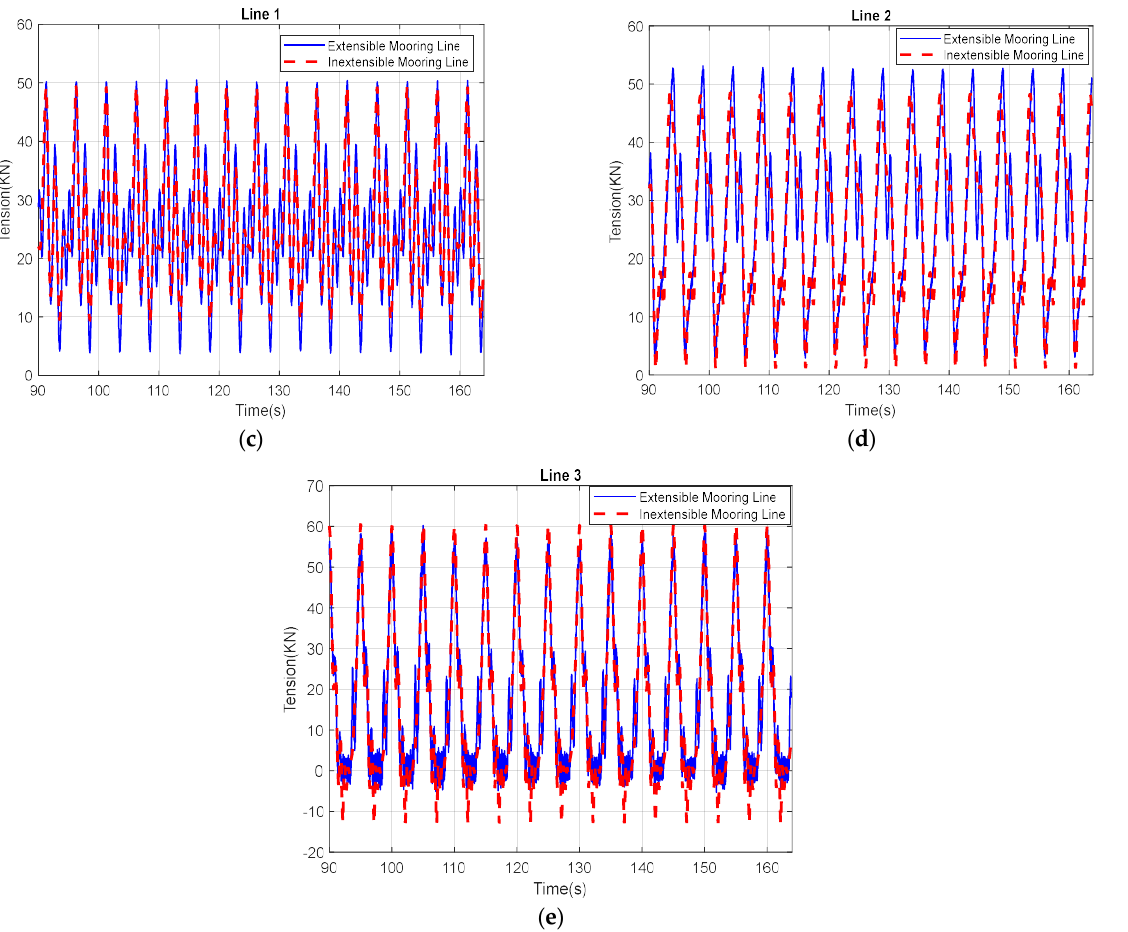
Figure 5. Comparison of time series of surge and heave motion time series, mooring tension at the fairlead using traditional stiff line model and proposed tensile mooring line model, ( a ) Surge ( b ) Heave ( c ) Line 1 ( d ) Line 2 ( e ) Line 3.